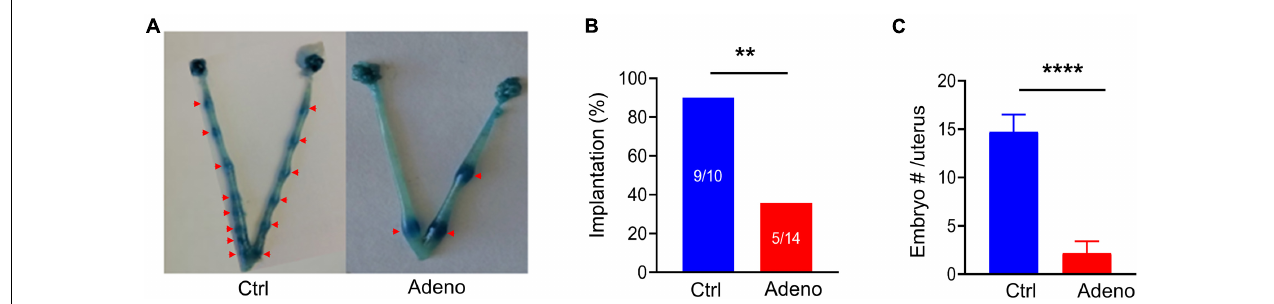
FIGURE 4 | Adenomyotic mice exhibit abnormal embryo implantations. (A) Embryo implantations in uteri from a mouse after treatment with the vehicle for tamoxifen (Ctrl) (left) or a mouse after treatment with tamoxifen (Adeno) (right), as revealed by Chicago Blue dye staining. (B) Incidence of successful implantations in mice after treatment with the vehicle (Ctrl) or after tamoxifen treatment (Adeno). Implantation (%) = mice with successful embryos/total mating mice*100; ** P < 0.01 by a Chi-Square test, N = 10 mice in the Ctrl group and 14 mice in the Adeno group. (C) Number of embryos in the Ctrl group and in the Adeno group. **** P < 0.0001 with unpaired Student’s t -test ( N = 9 mice, Ctrl vs. 5 mice,